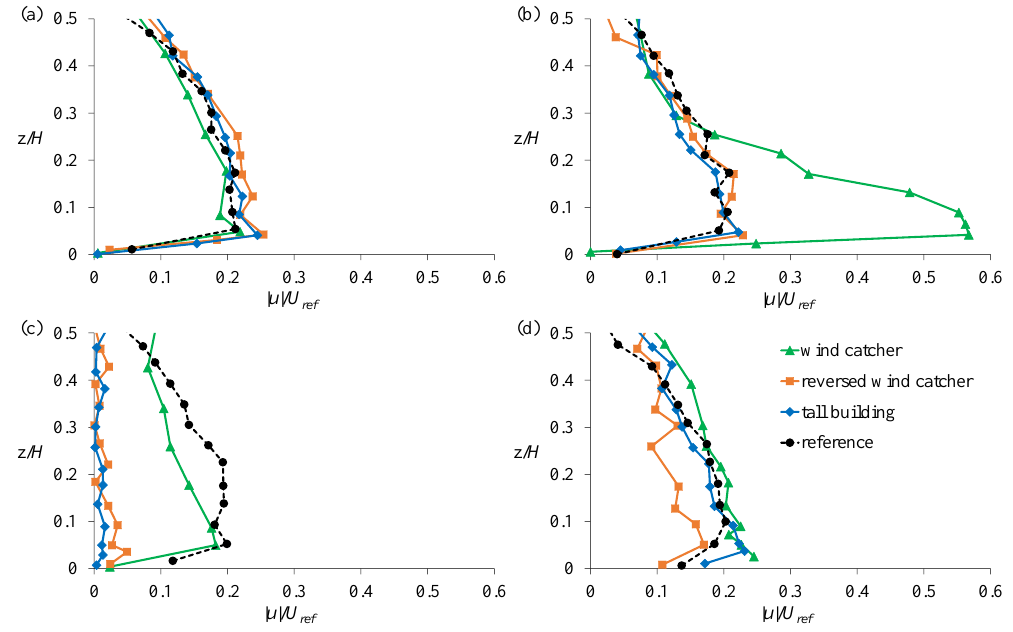
Figure 9. Normalized (absolute) stream-wise velocity comparing the cases with a wind catcher, a reversed wind catcher, and step-up/step-down canyons with reference to canyons of aspect ratio 1 in: ( a ) canyon 3, ( b ) canyon 4, ( c ) canyon 5, and ( d ) canyon